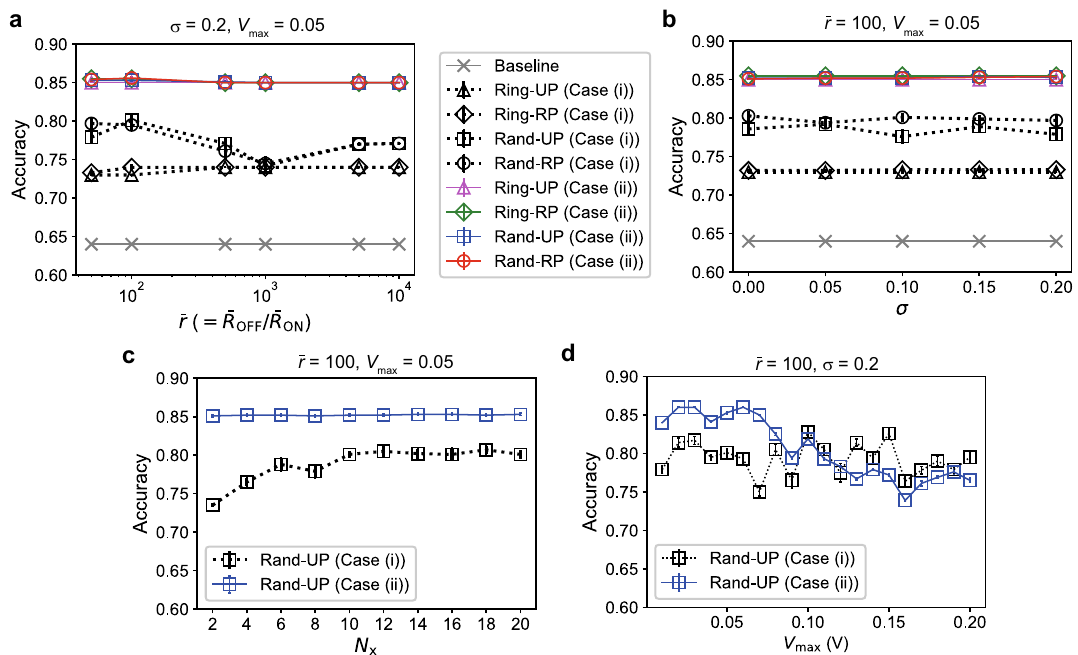
Figure 5. Results of the ECG classification task. ( a ) The classification accuracies for a variation of the average ON/OFF ratio ¯ r = ¯ R OFF / ¯ R ON . ( b ) The classification accuracies plotted against the variability parameter σ . The meanings of the marks are the same as those in ( a ). ( c ) The classification accuracies when N x signals out of N m ( = 20 ) current signals were used for the readout. ( d ) The dependence of the accuracy on the maximum input voltage V max